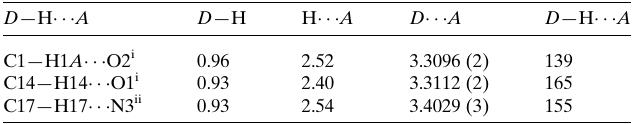
Table 1 Hydrogen-bond geometry (A˚ , (cid:2)